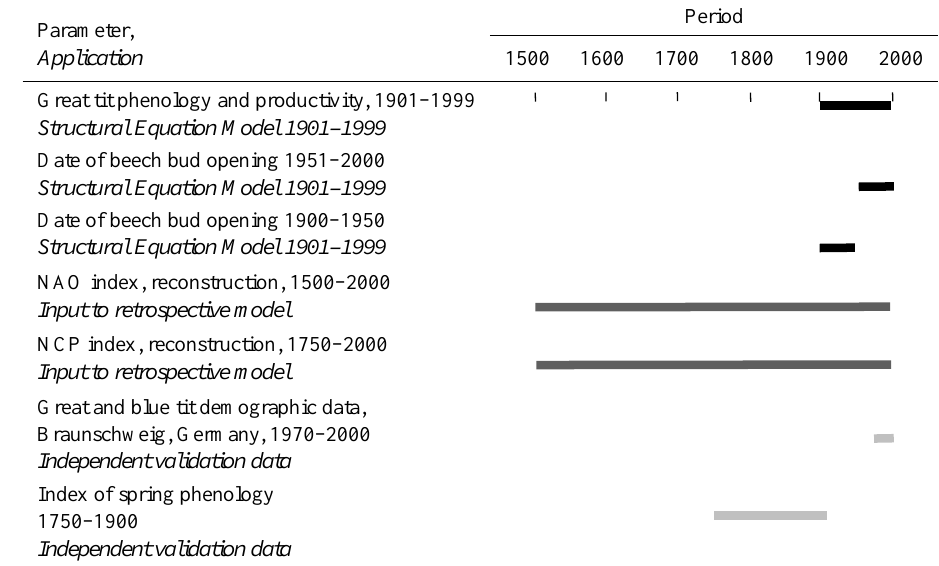
Table1. Overview of data series used in the analysis and models. Table 1. Overview of data series used in the analysis and models. Parameter, Parameter,